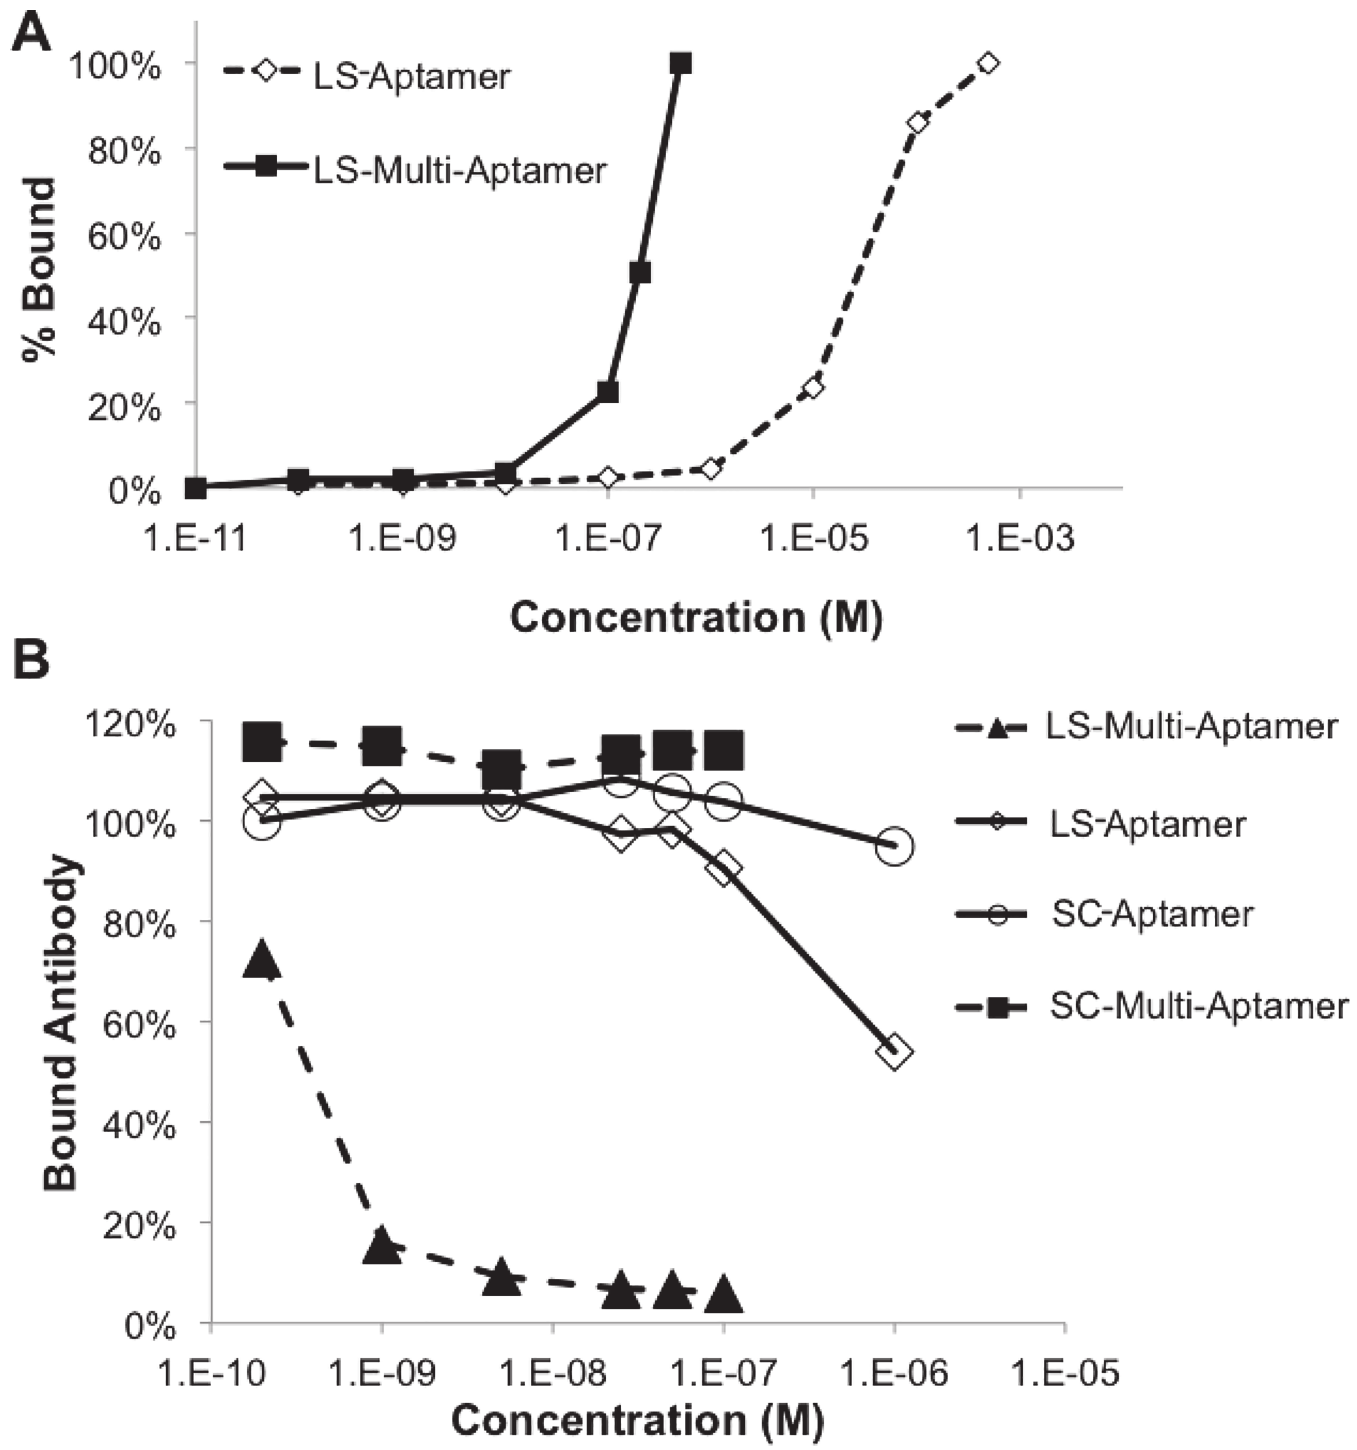
Fig 4. LS-Multi-Aptamer has a higher binding affinity for L-selectin than the monovalent aptamer. (A) Jurkat cells were incubated with fluorescent monovalent L-selectin aptamer (LS-Aptamer) or the LS-Multi-Aptamer at the indicated concentrations and fluorescence assessed with flow cytometry. (B) Jurkat cells were simultaneously treated with FITC-labeled blocking antibody, DREG56 (100 nM) and increasing concentrations of the indicated reagents. The mean fluorescence for each sample is normalized to the mean fluorescence of the untreated sample labeled with FITC-DREG56.